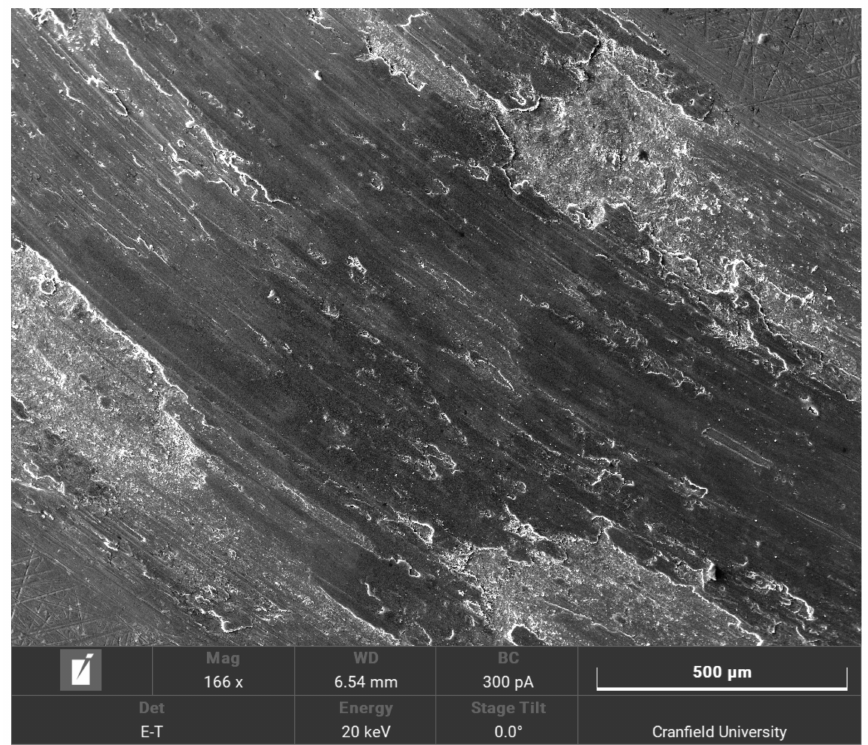
Figure 6. SEM image of the aluminium